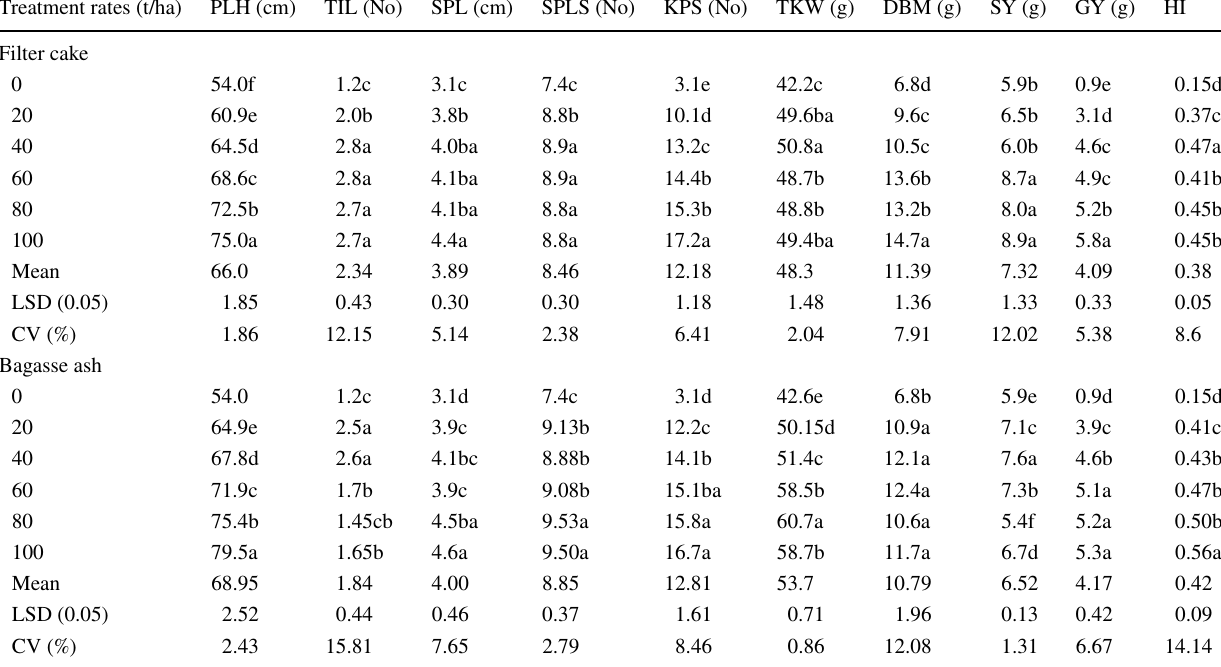
Table 6 Effect of filter cake and bagasse ash application on wheat yield and yield components